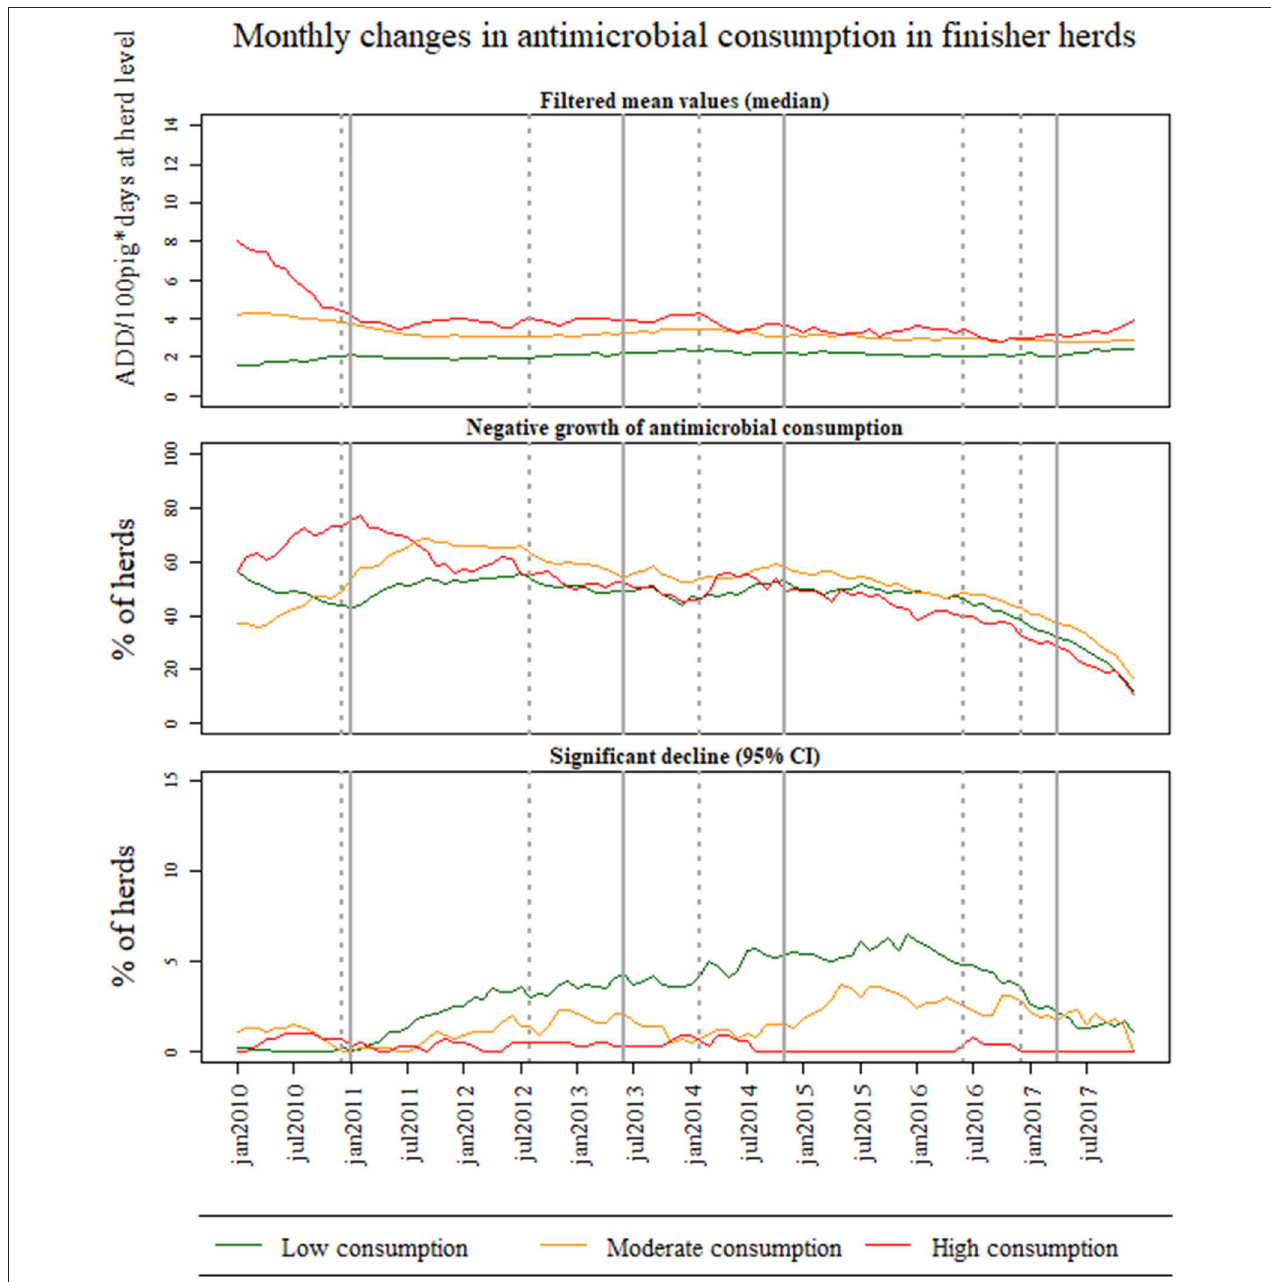
FIGURE 4 | Monthly changes in antimicrobial consumption in Danish finisher herds between January 2010 and December 2017 for all Danish farms. The farms were divided into three groups based on the level of antimicrobial use (low, medium, and high) in 2008 and 2009. For each group of antimicrobial consumption, the graphs depict (1) the median of the filtered mean values obtained at farm-level based on the Dynamic Linear Model (DLM) with a linear trend component, (2) the percentage of herds with negative growth based on the DLM, and (3) the percentage of herds with a significant decline on the trend component of the DLM using 95% credible intervals